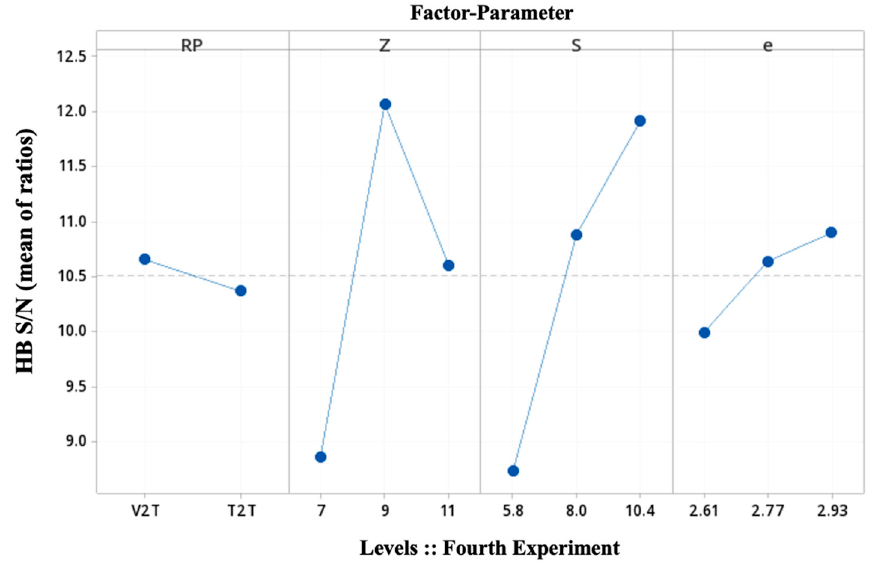
Figure 15. Main effects plot for the fourth Taguchi experiment (see Table 7).